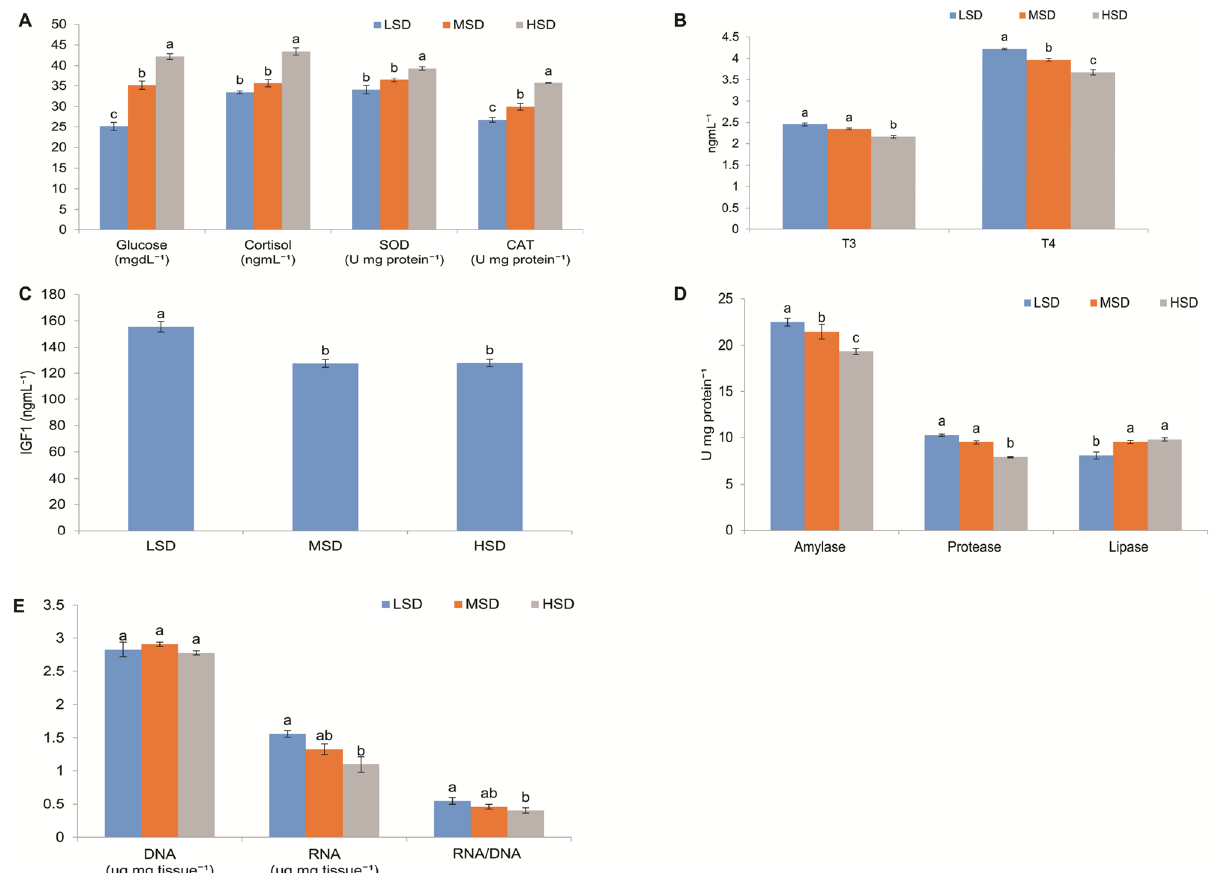
Figure 1. Activities of ( A ) glucose, cortisol, superoxide dismutase (SOD), catalase (CAT) in serum ( B ) triiodothyronine (T3) and thyroxine (T4) in serum, ( C ) insulin like growth factor 1 (IGF1) in serum, ( D ) amylase, protease and lipase in the gut, and ( E ) concentration of DNA, RNA and RNA/DNA ratio in the muscle of L. rohita stocked at three different stocking densities. Each bar represents values as mean ± SE. Within endpoints and groups, bars with different superscripts (a, b, c) are significantly different ( P < 0.05).